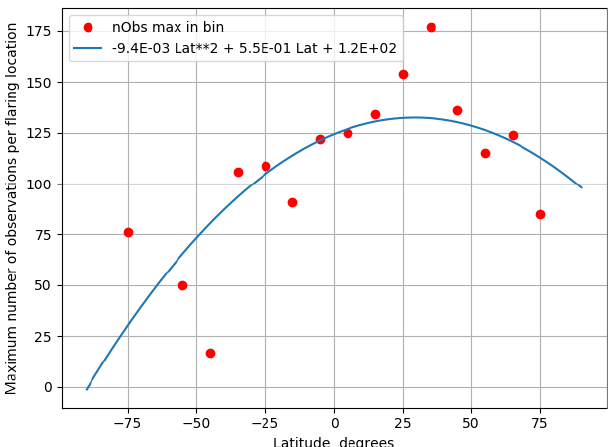
Figure 2. Maximum number of observations per grid cell as a func- tion of latitude. The latitude values are binned (10 ◦ ). The function expresses the maximum number of observations n Obs assume as a continuous operation of the hot source, as a function of